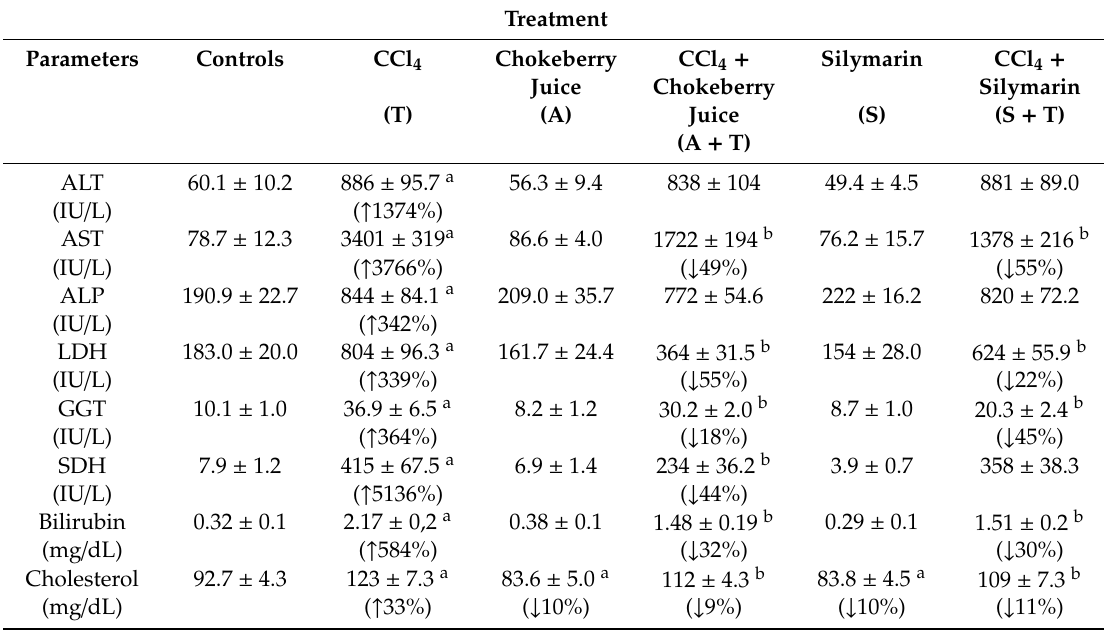
Table 2. E ff ect of chokeberry juice or silymarin on serum parameters in rats treated with carbon